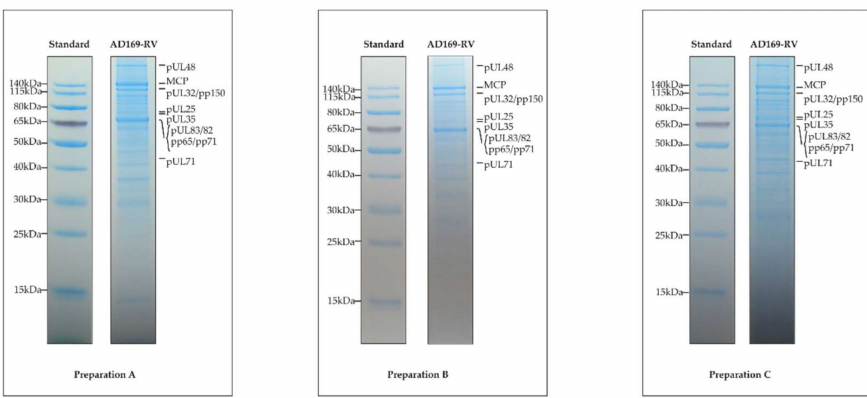
Figure 1. Protein patterns of the three replicates of purified human cytomegalovirus (HCMV) virions. Extracted proteins of the three di ff erent preparations were submitted to SDS-PAGE separation and stained with Instant Blue dye. The proteins depicted to the right in each panel were tentatively assigned according to the protein molecular weight standard, shown to the